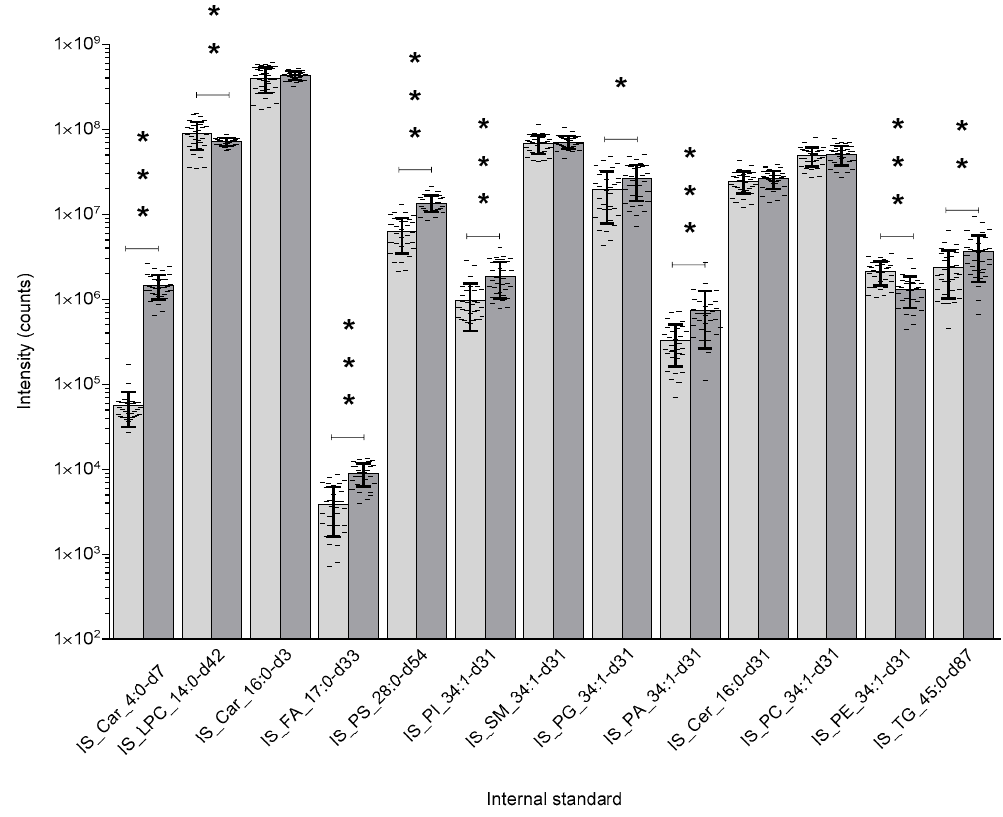
Figure 1. This figure shows the comparison between the two lipid extraction techniques